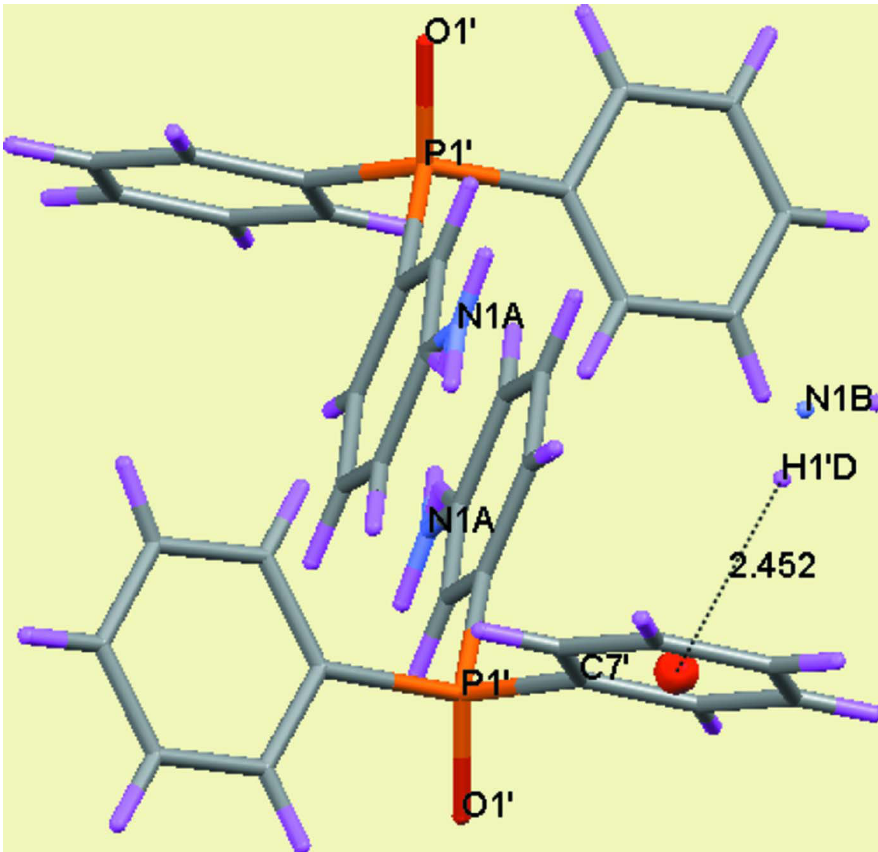
Figure 5 N—H··· π Stacking interactions between between N–H group of aniline and phenyl rings with H··· π distances of 2.45 Å for N1B—H1′D··· Cg 3 (1 - x , 1 - y , 1 - z ) [ Cg 3 is the centroid for C7′-C12′